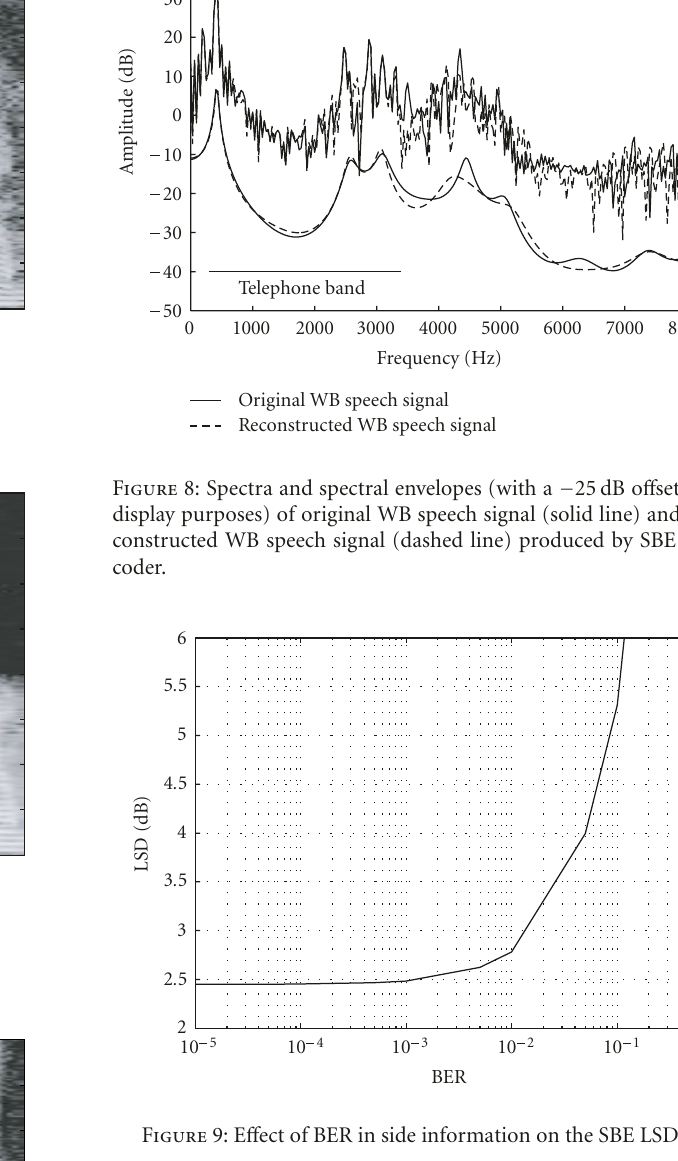
Since the telephone channel has a large attenuation in the frequency ranges of 0–300 Hz and 3400–4000 Hz, the full band is partitioned into M = 8 nonuniform subbands, as follows: from each frame containing 256 DHT coe ffi - cients, the positive and negative frequency coe ffi cients of the first subband (0–312 . 5 Hz, with the start and end indices of the first subband positive frequency boundaries equal to k 0,start = 0 and k 0,end = 10, resp.), and of the positive and negative frequency coe ffi cients of the last subband (3343 . 75– 4000 Hz, with the start and end indices of the last subband positive frequency boundaries equal to k 7,start = 107 and k 7,end = 128, resp.), are not used for data embedding. The frequency range 343 . 75–3312 . 5 Hz (with the